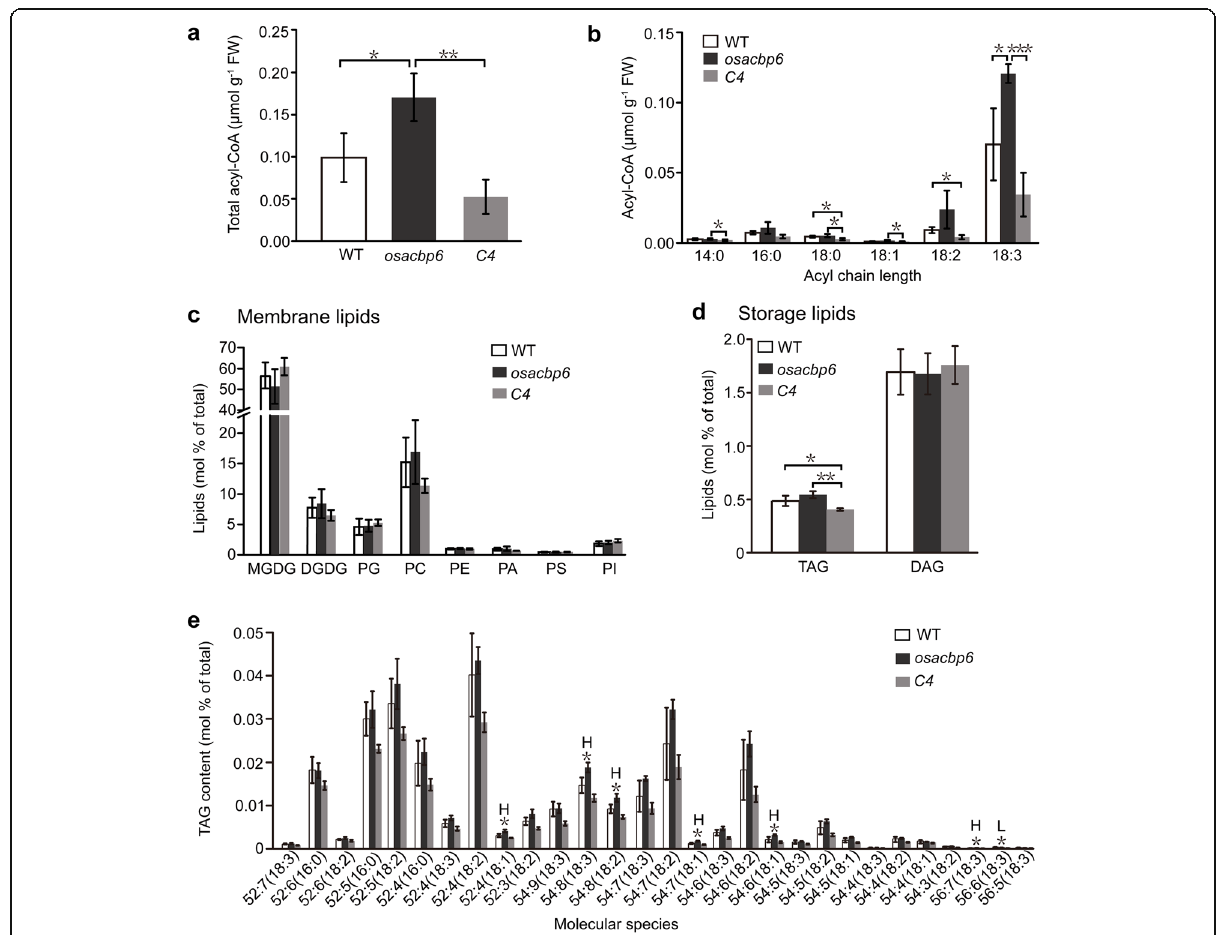
Fig. 4 Acyl-coenzyme A (CoA) and lipid profiles of 21-day-old leaves. a Comparison of total acyl-CoA content of the wild type rice (WT), the osacbp6 mutant and the complemented line osacbp6-C4 ( C4 ). b The concentration of different acyl-CoA species. c Membrane lipid content (mol % of total lipids analyzed). Values are means ± SD ( n = 3). d Storage lipid content (mol % of total lipids analyzed). Values are means ± SD ( n = 3). e The abundance of selected individual TAG molecular species (mol % of total) in 21-day-old leaves of the rice osacbp6 mutant, WT, and C4 . Values are means ± SD ( n = 3). H, value of osacbp6 is higher than WT; L, value of osacbp6 is lower than WT. Values of C4 are all significantly lower than osacbp6 as evaluated by Student ’ s t -tests. Asterisks indicate significant differences as evaluated by Student ’ s t -tests: * P < 0.05, ** P < 0.01, *** P < 0.001. FW, fresh weight; WT, Oryza sativa var. japonica cv. Dongjin. DAG, Diacylglycerol; TAG, Triacylglycerol;